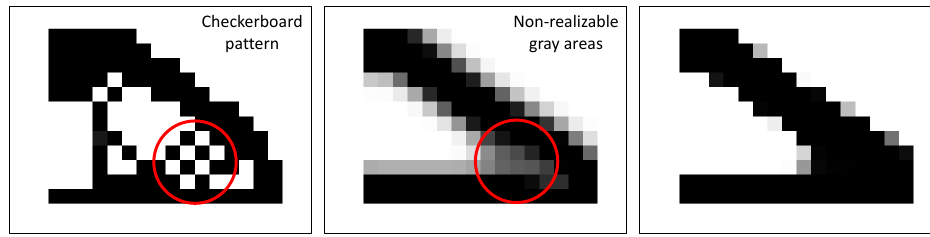
Figure 3. Filter techniques in TO. Left : A TO-obtained structure without any filter. Center : Same optimization with a density filter. Right : Same optimization with both filters